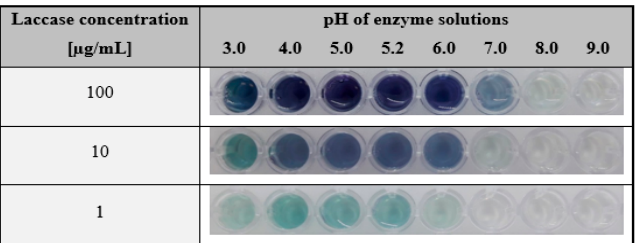
Figure 5. The results of the colourimetric test for the different concentrations of laccase in phosphate-citrate buffer with fixed pH values. The comparison of the detection level of enzymatic activity was examined for laccase concentrations of 100, 10, and 1 µg/mL and in the pH range of 3.0–9.0. Test conditions: hydrogel gelatine matrices containing ABTS at a concentration of 1.5 mg/mL; test time: 60 min.